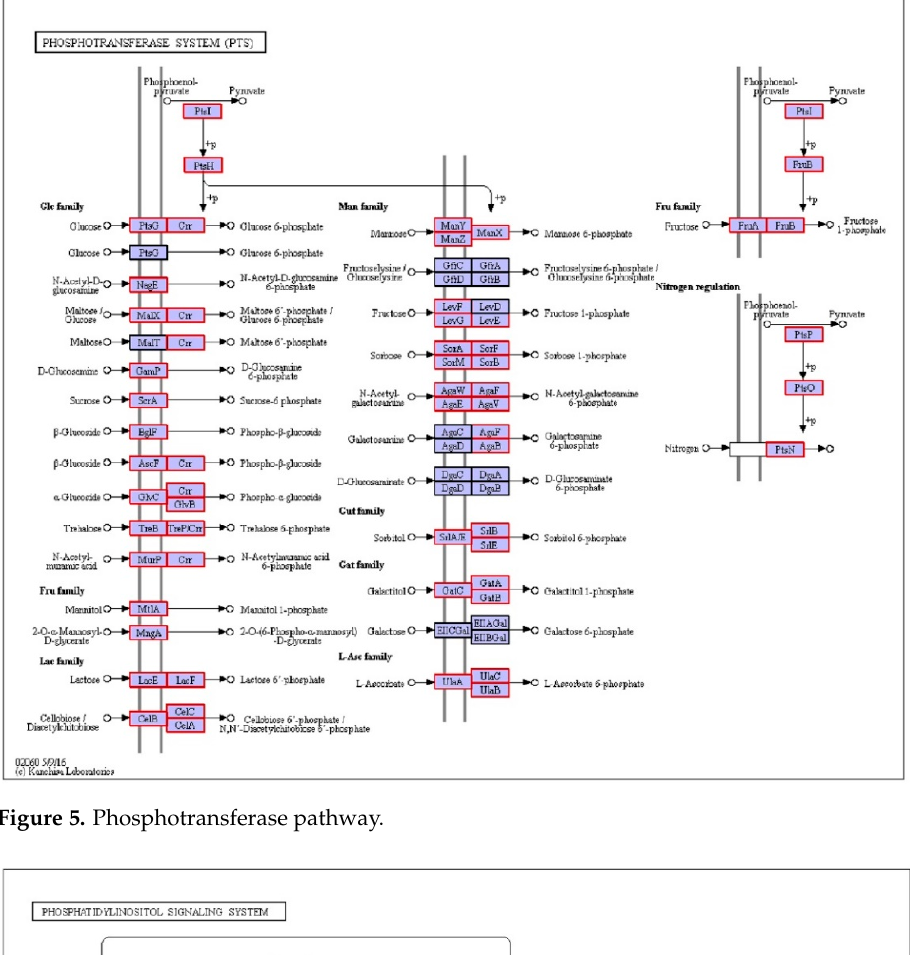
Figure 5. Phosphotransferase pathway.